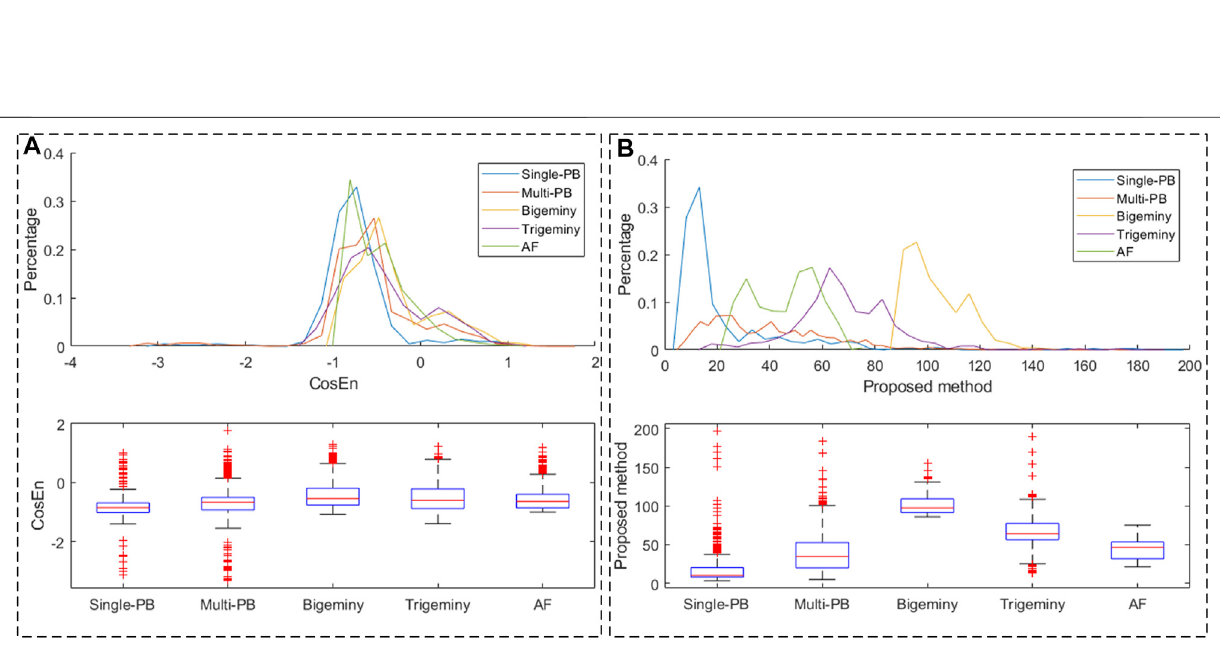
Frontiers in Physiology |